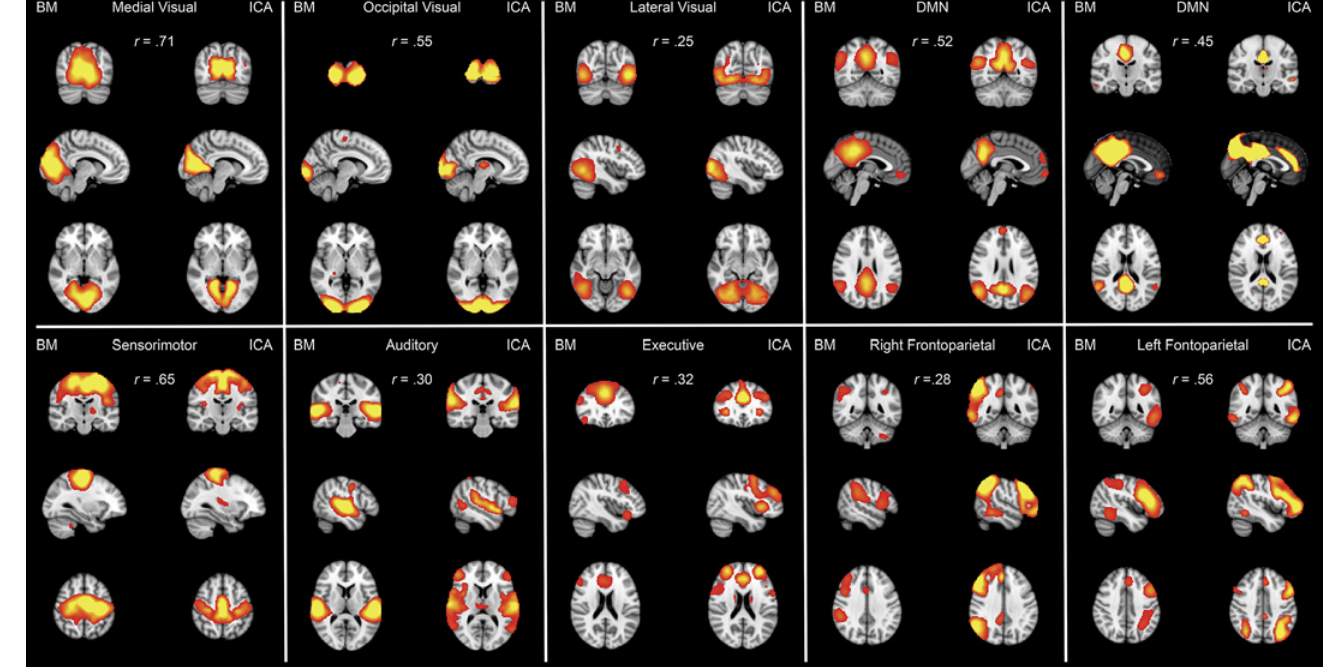
Fig 3. BrainMap components are well matched to ICA components. Ten ICNs from the analysis of the 29,671-subject BrainMap activation database (Right column of each pair: [37]) paired to 10 ICNs that were selected out of 20 components from the ICA analysis of the current rs-fMRI dataset (right column). The networks were paired using spatial cross-correlation with mean r = .46 (range = .25 – .71); the weakest of these correlations thus has a significance of P = 10 − 5 (corrected). All ICA spatial maps were converted to Z statistic images via a normalized mixture – model fit, and then thresholded at Z = 3. The figure shows the 3 most informative orthogonal slices for each pair. ICNs are displayed in a gradient from red to yellow (3 < Z < 5), superimposed on the MNI152 standard space template image, in radiological convention (left = right). The r statistic is displayed at the top of each panel.